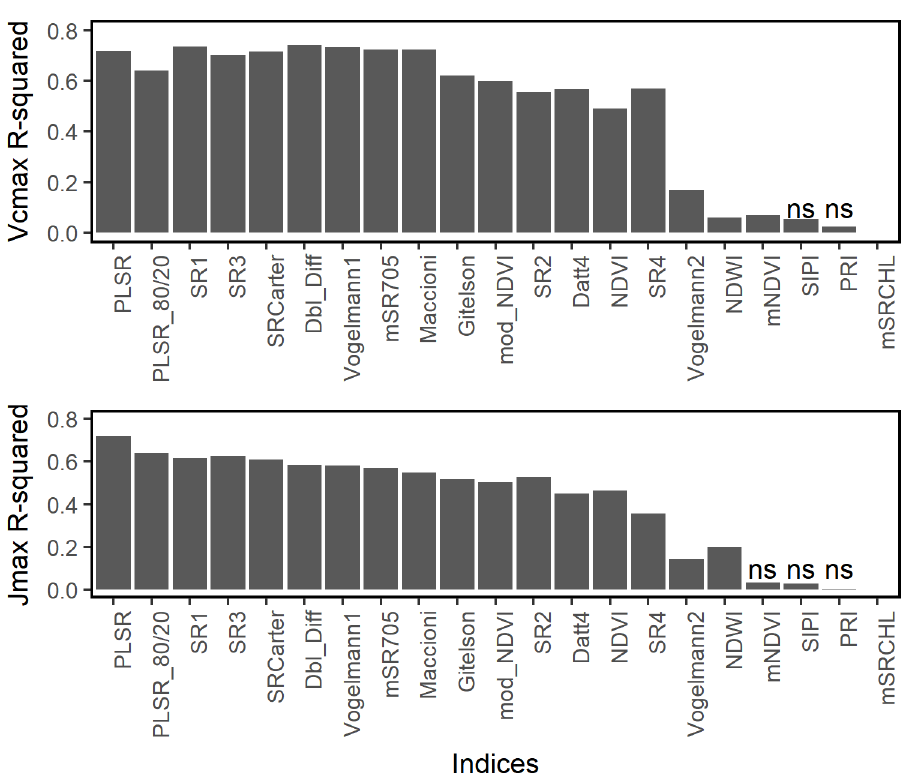
Fig 4. Comparison of predictive abilities of hyperspectral indices and PLSR models. Predictive capability for (A) maximum rates of RuBP carboxylation (V cmax , μ mol m -2 s- 1 ) and (B) RuBP regeneration J max ( μ molm -2 s- 1 ). PairwisecorrelationsbetweenV cmax and J max estimated using standard gas exchange techniques and spectral indiceswere tested and R 2 is reported. The R 2 reportedfor the PLSR model is from the leave-one-out cross-validation approach. Indices with non-significant correlationsare representedwith “ns”.